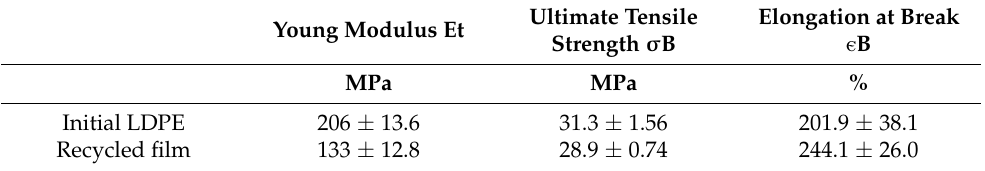
Table 5. Overview of the results of the tensile test of the recycled and the initial LDPE film.